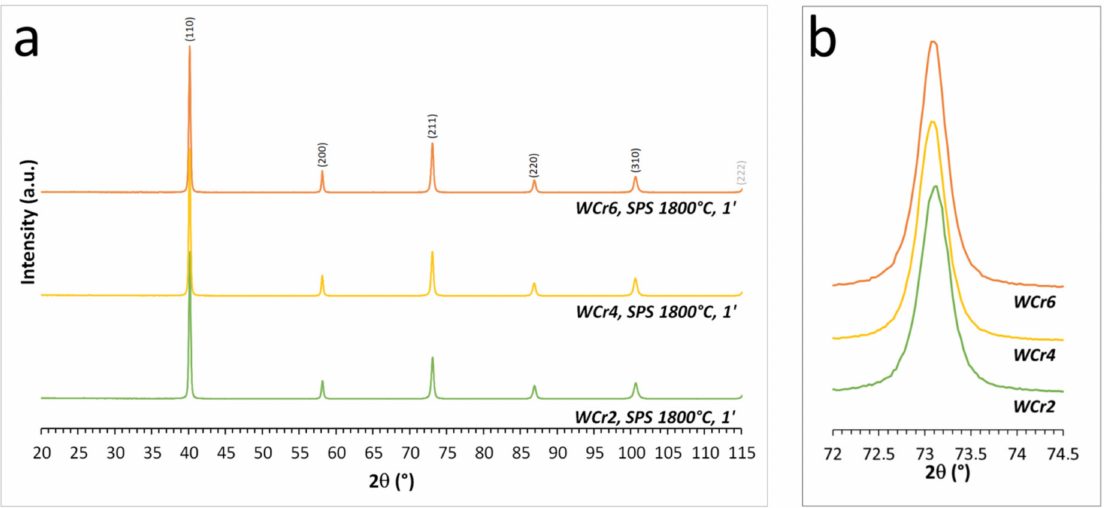
Figure 5. ( a ) XRD patterns of SPS sintered samples. Miller indices represented correspond to the expected tungsten BCC crystal structure. ( b ) magnification of the (211) peak.